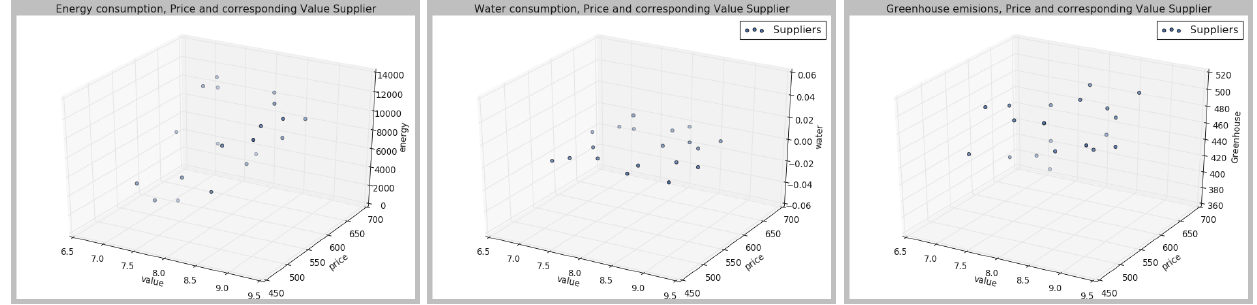
Figure 5. Case 3, according to the preferences described in Table 3.